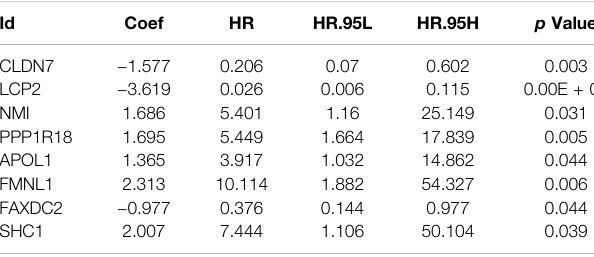
TABLE 1 | Multivariate Cox regression analysis of eight